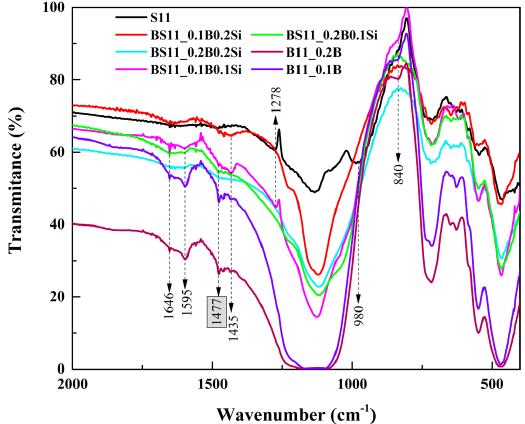
Figure 6. IR spectra in the range of 2000-400 cm -1 of AEL samples with and without boron added to different compositions.